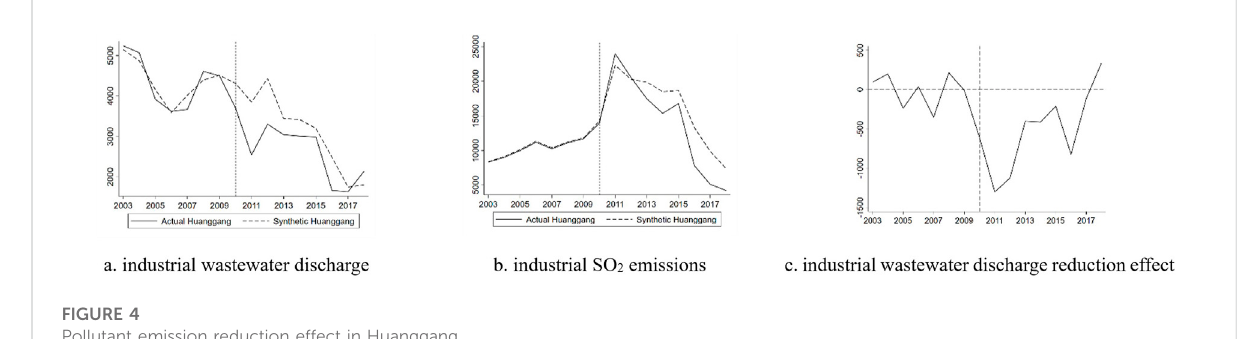
FIGURE 4 Pollutant emission reduction effect in